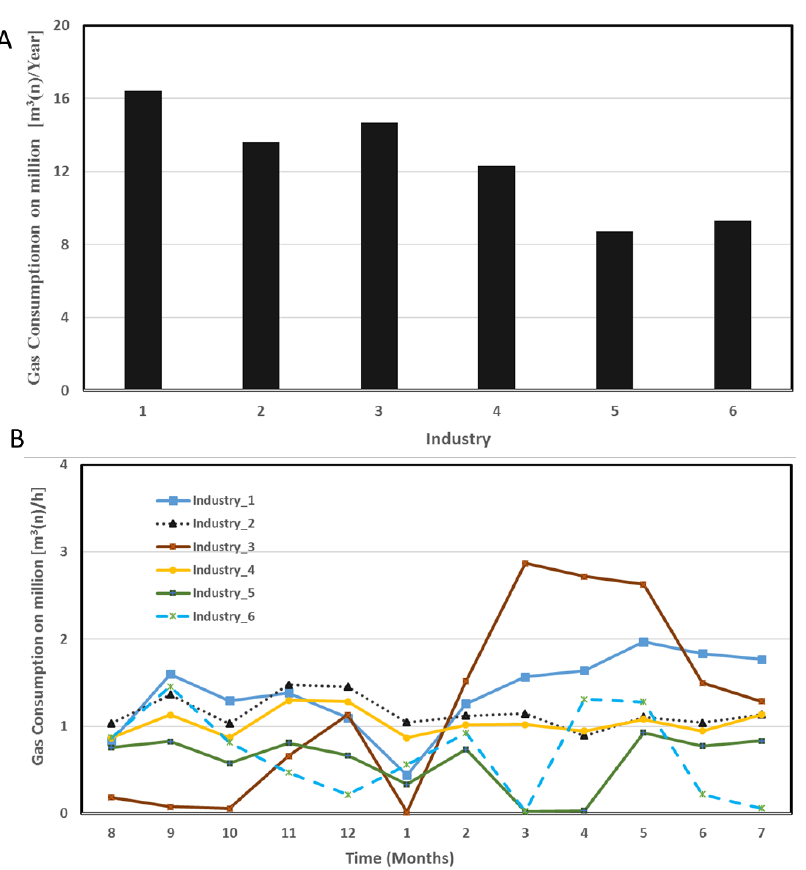
Figure 3. Gas consumption trend by different industries. ( A ) Yearly consumption; ( B ) Monthly Figure 3. Gasconsumptiontrendbydifferentindustries. ( A )Yearlyconsumption; ( B consumption.